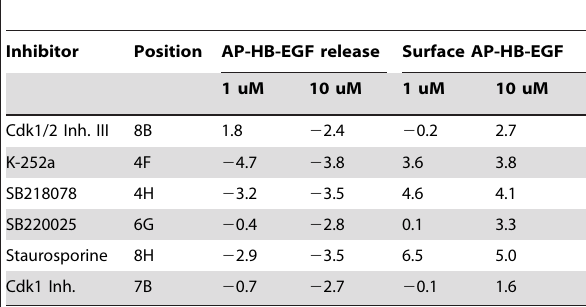
Table 2. Inhibitors with a z-score . 2 from InhibitorSelect TM Library